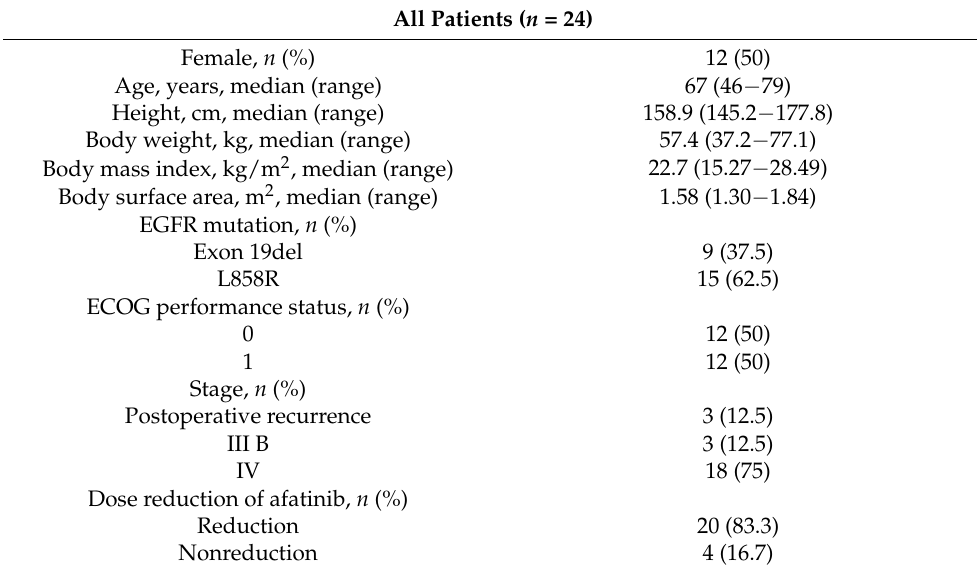
Table 1. Characteristics of patients in the